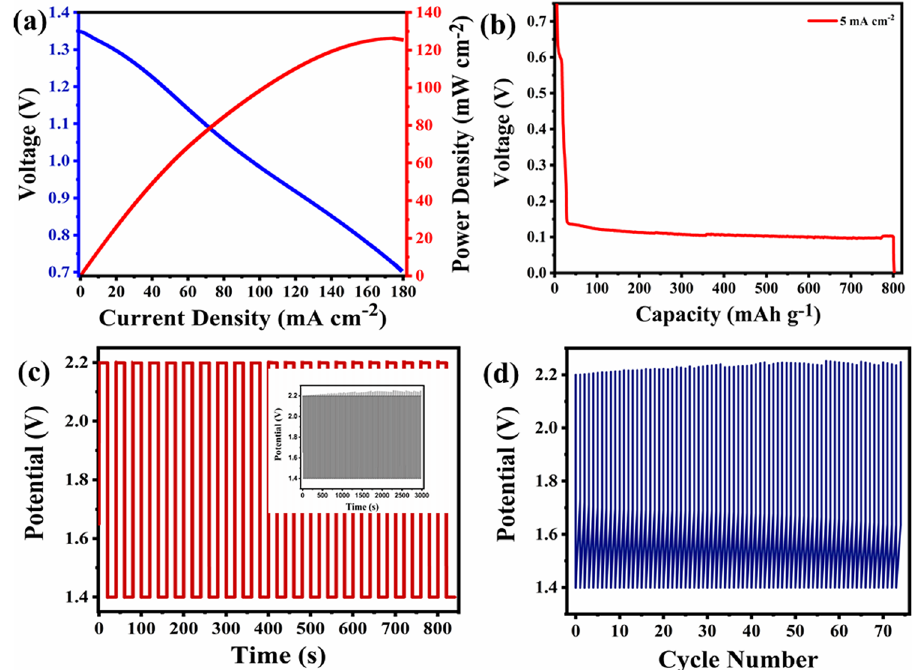
Figure 6. Performance of fabricated aqueous zinc–air battery. ( a ) Charge–discharge curve with the power density of CCTO; ( b ) discharge profile of CCTO at 5 mA cm -2 for continuous 17 h. ( c ) Charge/discharge (Chronopotentiometric) curve for CCTO at 20 mA cm -2 with the potential range of 1.4–2.2 V for an hour (insight: displays charge/discharge polarization (time vs. potential) with extended cycles); ( d ) shows Voltage vs. Number of